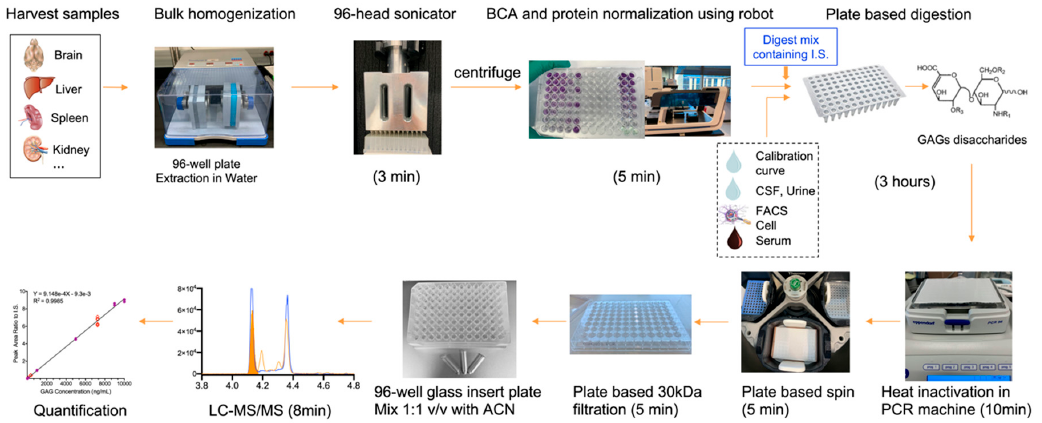
Figure 1. LC-MS/MS GAGs analysis using a robotic workstation-assisted and plate-based sample Figure 1. LC-MS / MS GAGs analysis using a robotic workstation-assisted and plate-based sample preparation workflow. preparation